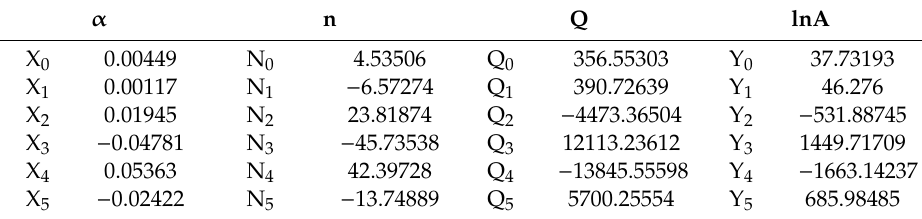
Table 5. Polynomial fitting results of a, lnA , n, Q in β phase region.